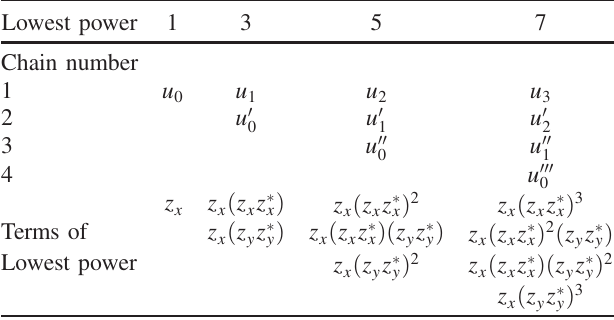
TABLE II. Terms with lowest power in chains. Lowest